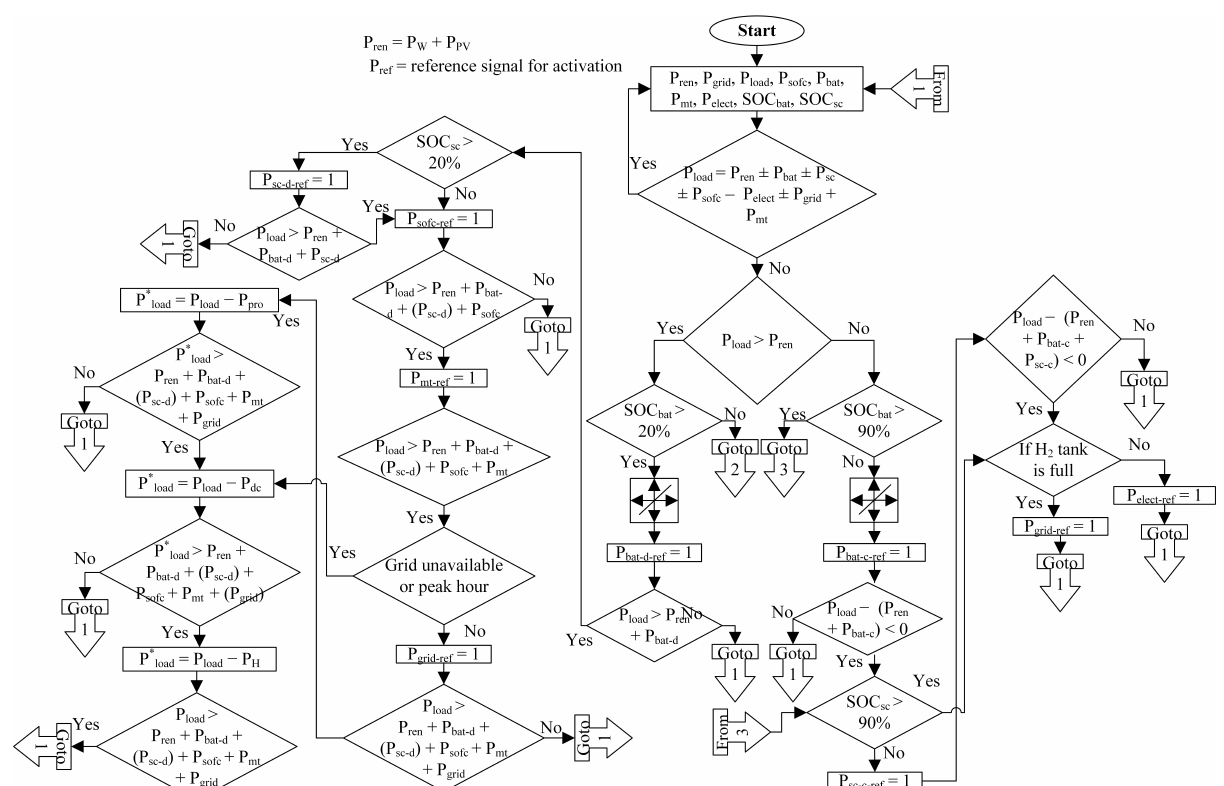
Figure 2. Flow chart for supervisory control system. * shows the new/required